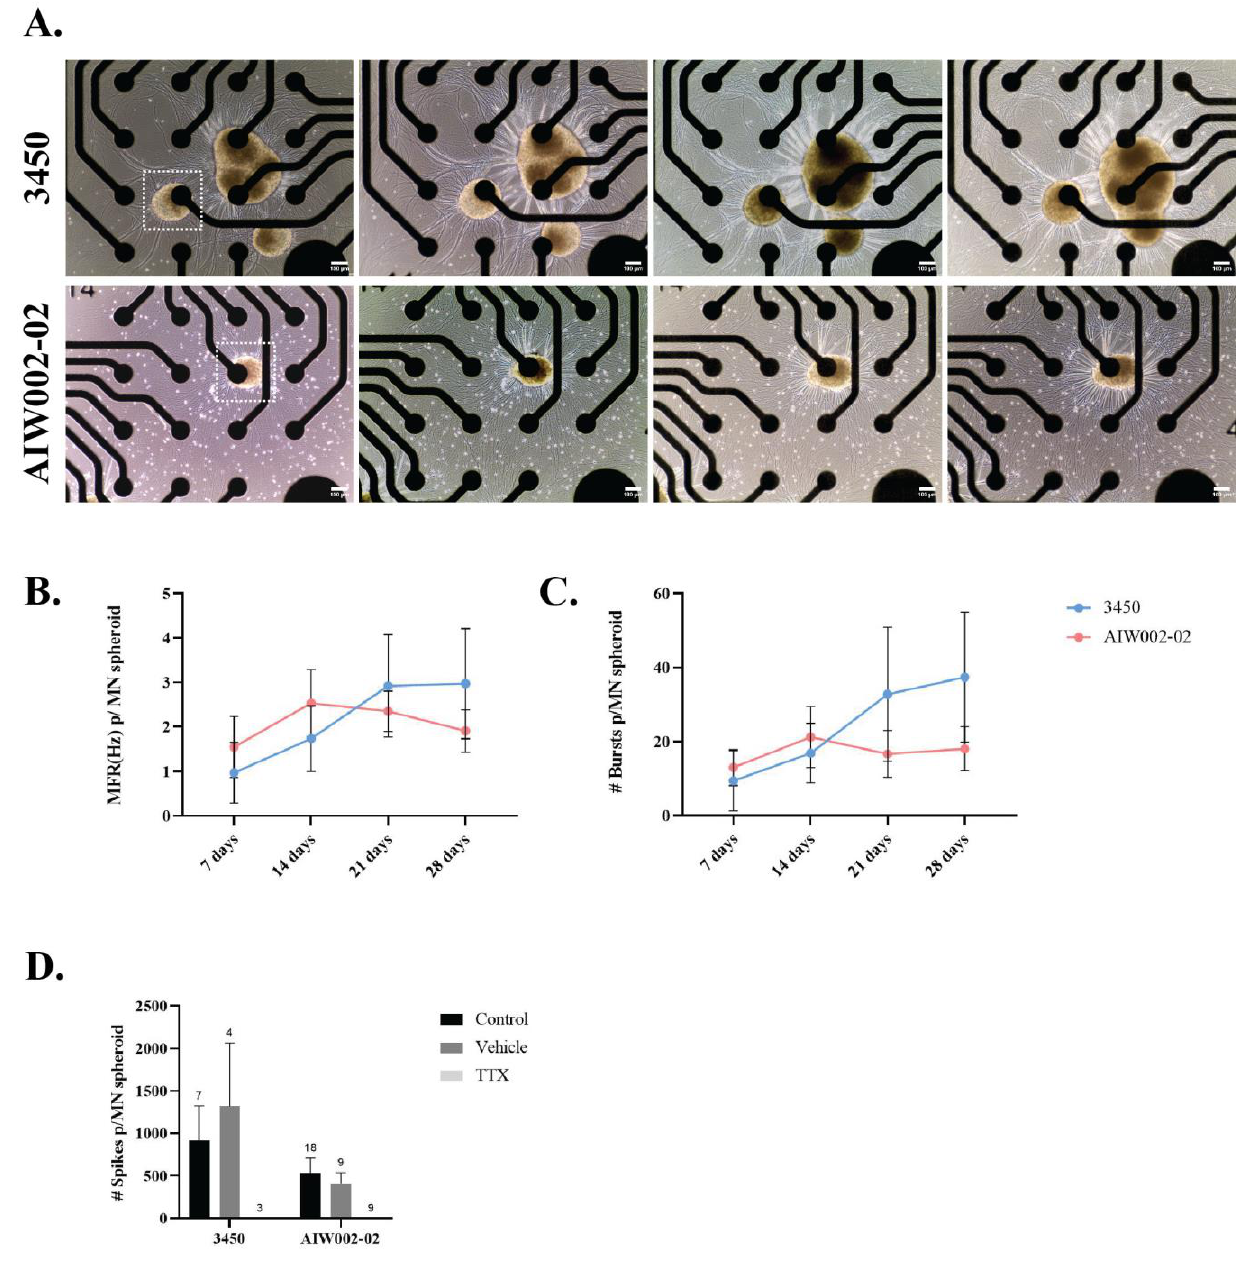
Figure 5. Spontaneous firing activity of iPSC-derived MN spheroids at different time points. ( A ) iPSC-derived MN spheroids were plated on wells of Cytoview 24-well MEA plates and recorded every 7 days until 28 days. Only MN spheroids placed at the center of an electrode (squares) through the entire recording time were considered for quantification. ( B ) Mean firing rate (MFR) and ( C ) number of bursts were plotted per individual MN spheroid. The connected scatter plots show the mean ± SEM; for each cell line, each batch of three batches of iPSC-derived MNPCs generated through independent differentiation processes were used to generate one MN spheroid batch. A minimum of nine MN spheroids were required for quantification to ensure that at least three spheroids per MNPC batch were quantified. ( D ) Tetrodotoxin (TTX) treatment blocked all firing in MN spheroids, ruling out system artifacts and confirming neural activity for both cell lines. H 2 O was used as vehicle. Graph bars show mean ±